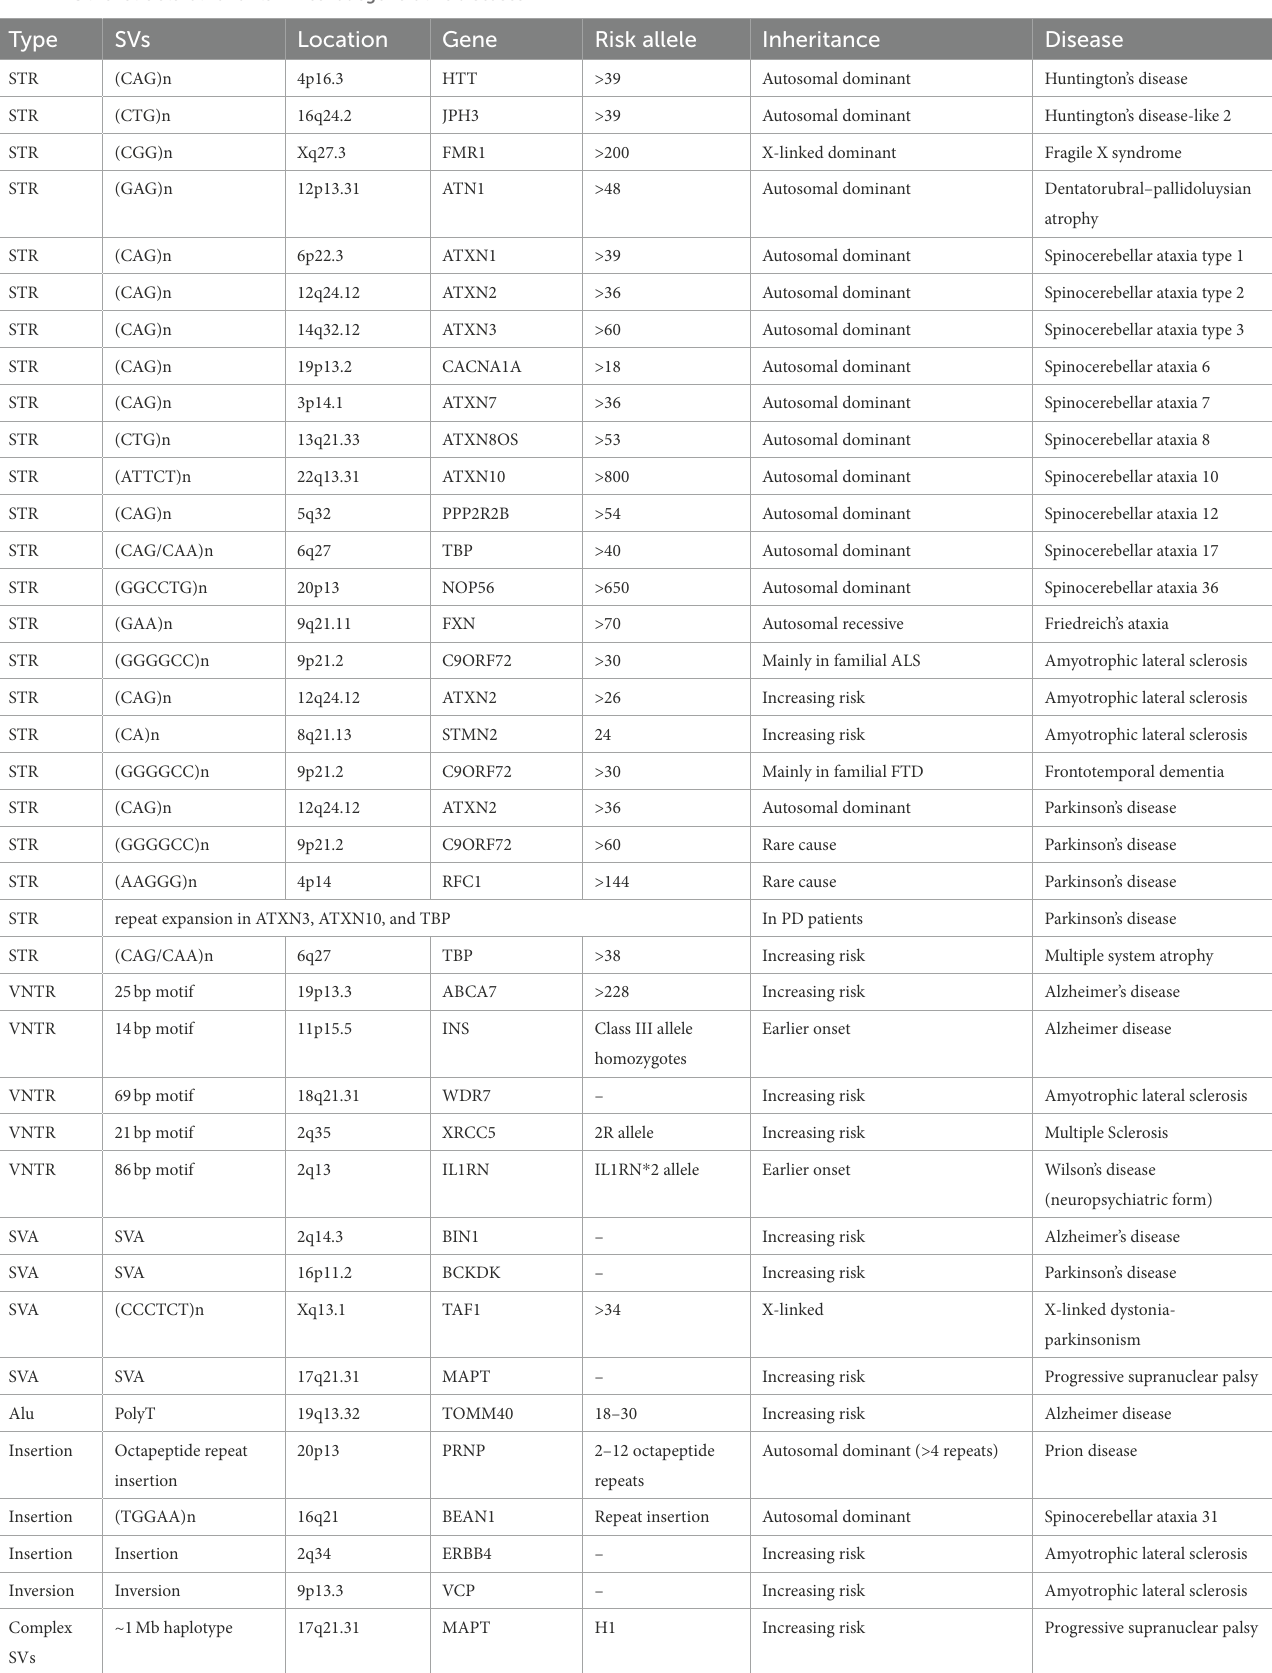
TABLE 2 Other structural variants in neurodegenerative